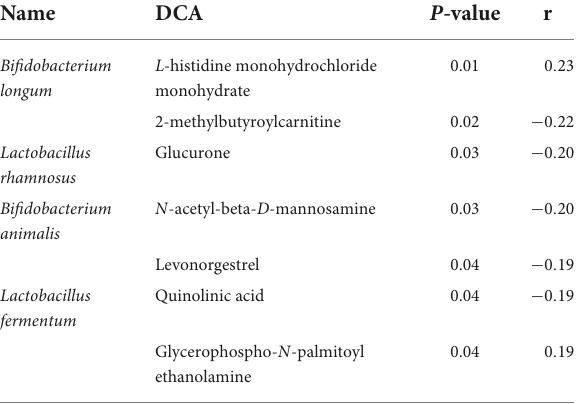
TABLE 4 Correlation analysis between significantly changed probiotics and